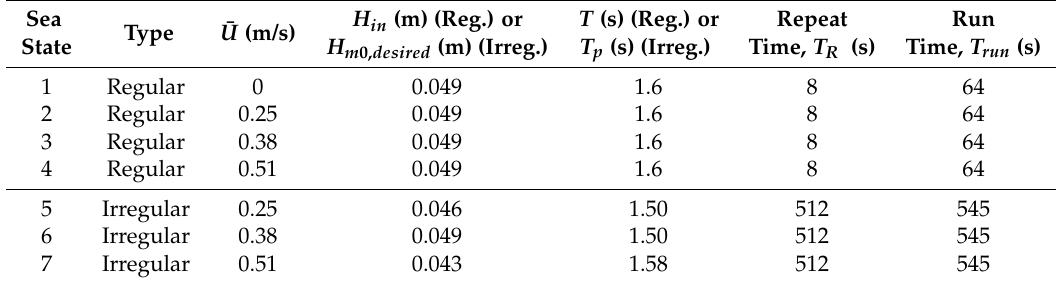
Table 3. Wave-current test plan for generation at FloWave. The 1:22.5 Froude scale compared with the Fall of Warness tidal test site. Each sea state is generated five times to measure at different depths with the ADV. Note that Reg. and Irreg. correspond to regular and irregular wave conditions respectively.